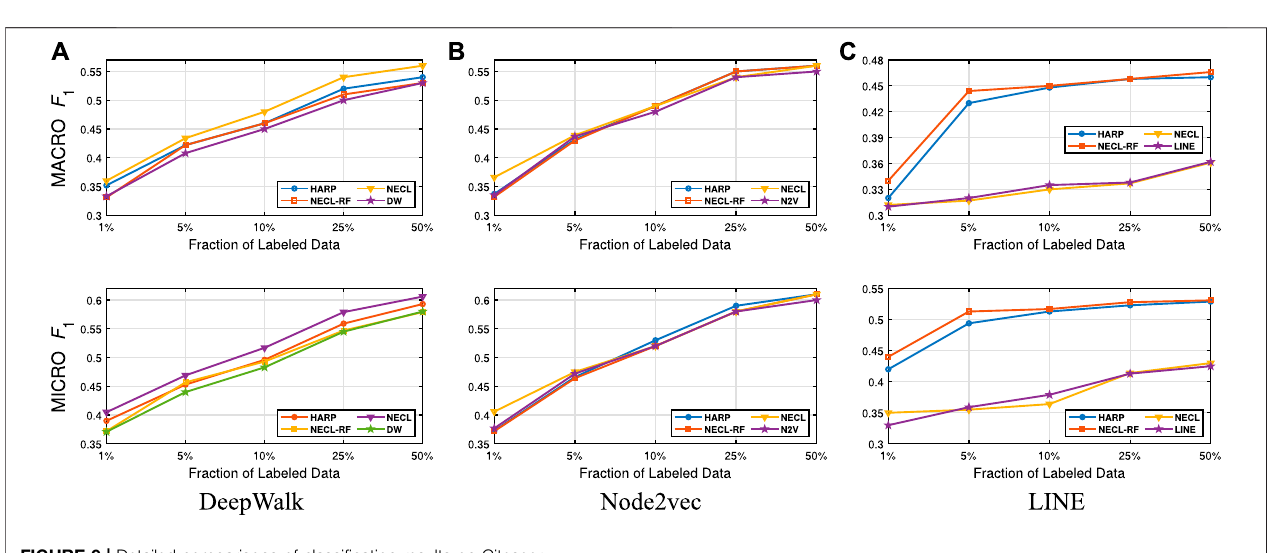
FIGURE 9 | Detailed comparisons of classi fi cation results on Citeseer